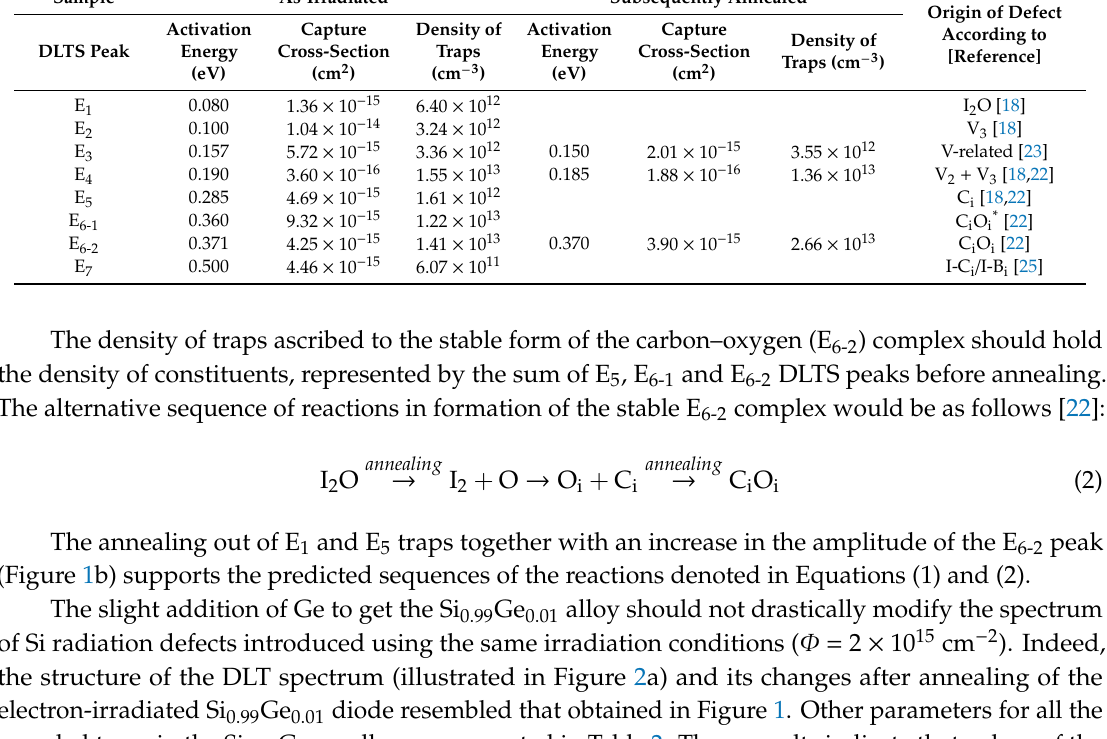
Table 1. Traps revealed for the 5.5 MeV electron as-irradiated and subsequently annealed Si sample.